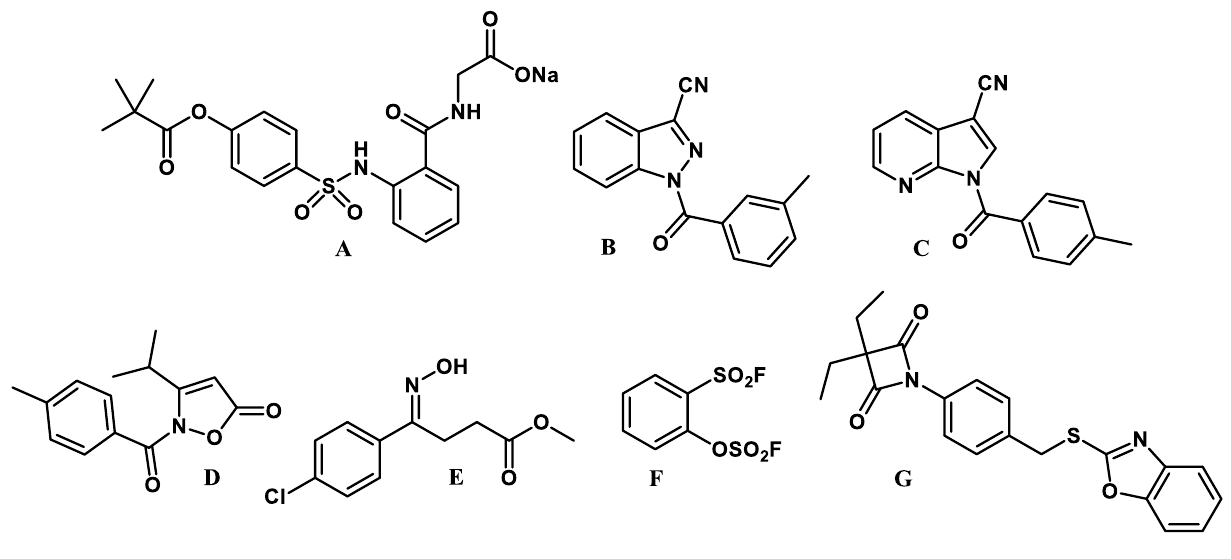
Figure 1. Structures of selected HNE inhibitors.